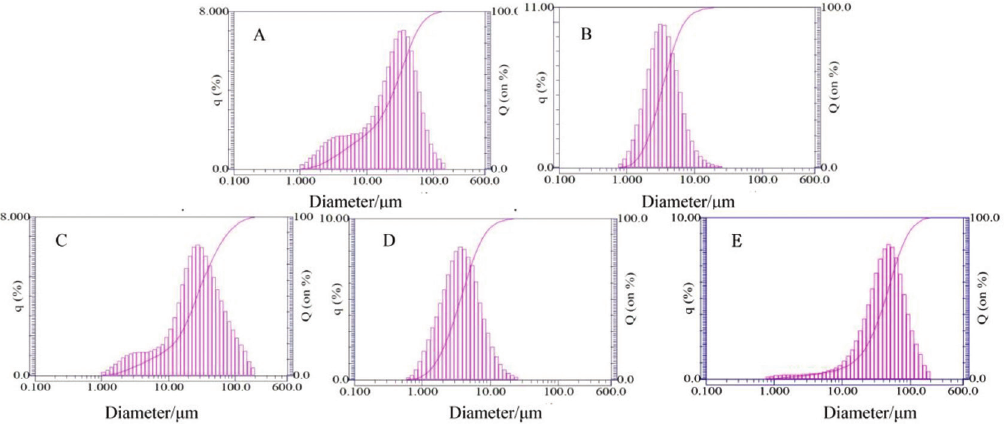
Figure 3: Particle size distribution of the microspheres: (a) HA-AMA, (b) HA-BDDA, (c) HA-PETRA, (d) HA-DVB, (e) HA-TMPTA.